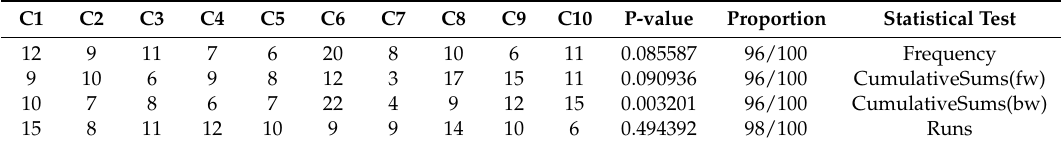
Table 2. Basic NIST tests evaluated for the sequences provided by RND cells.